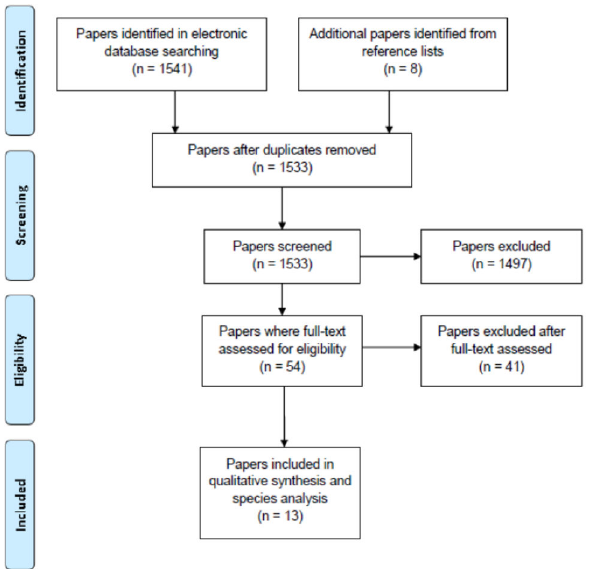
Figure 1. Flow chart using the PRISMA statement for the systematic review.